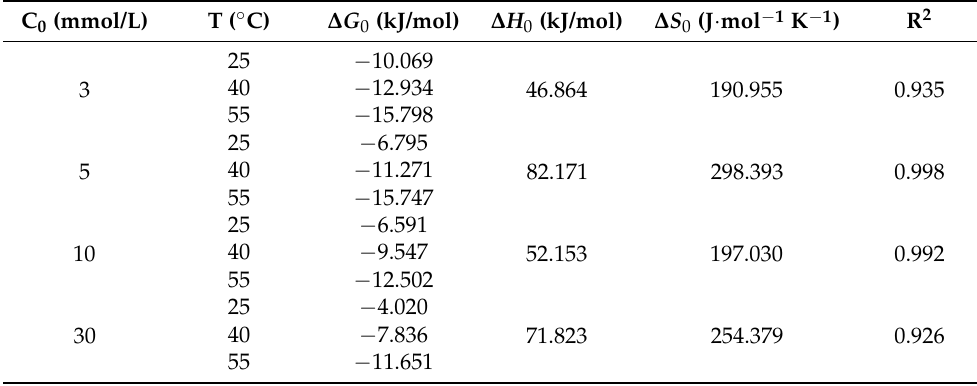
Figure 9. Adsorption thermodynamic model. Table 5. Adsorption thermodynamic parameters.